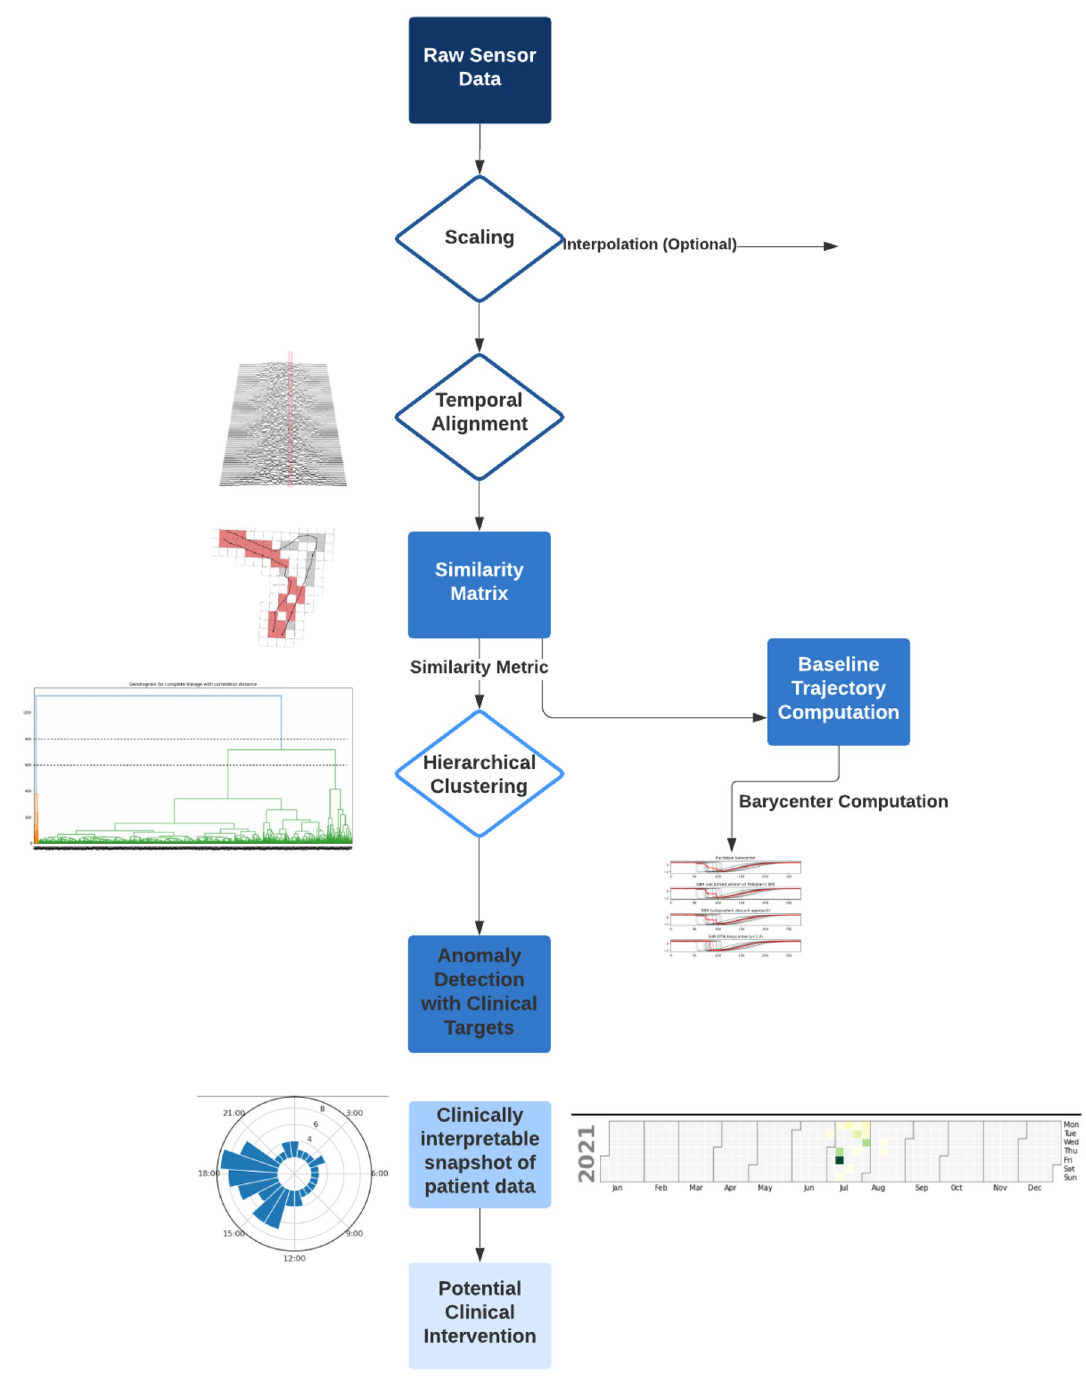
Figure 4. TAS method